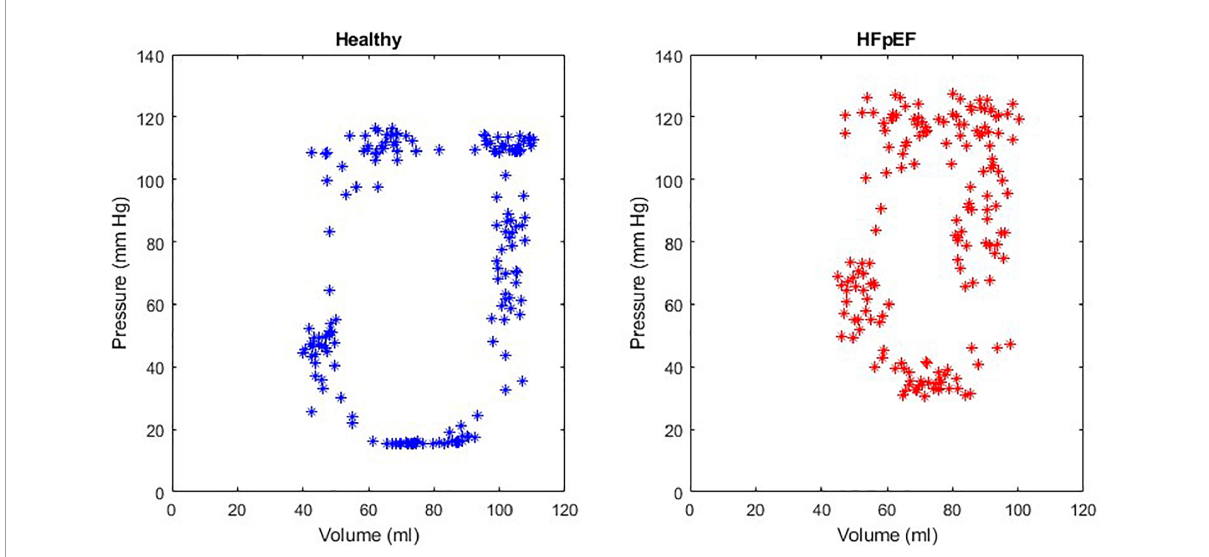
FIGURE5 An example of a healthy PV loop and HFpEF PV loop generated from data recorded on the MCL Mk